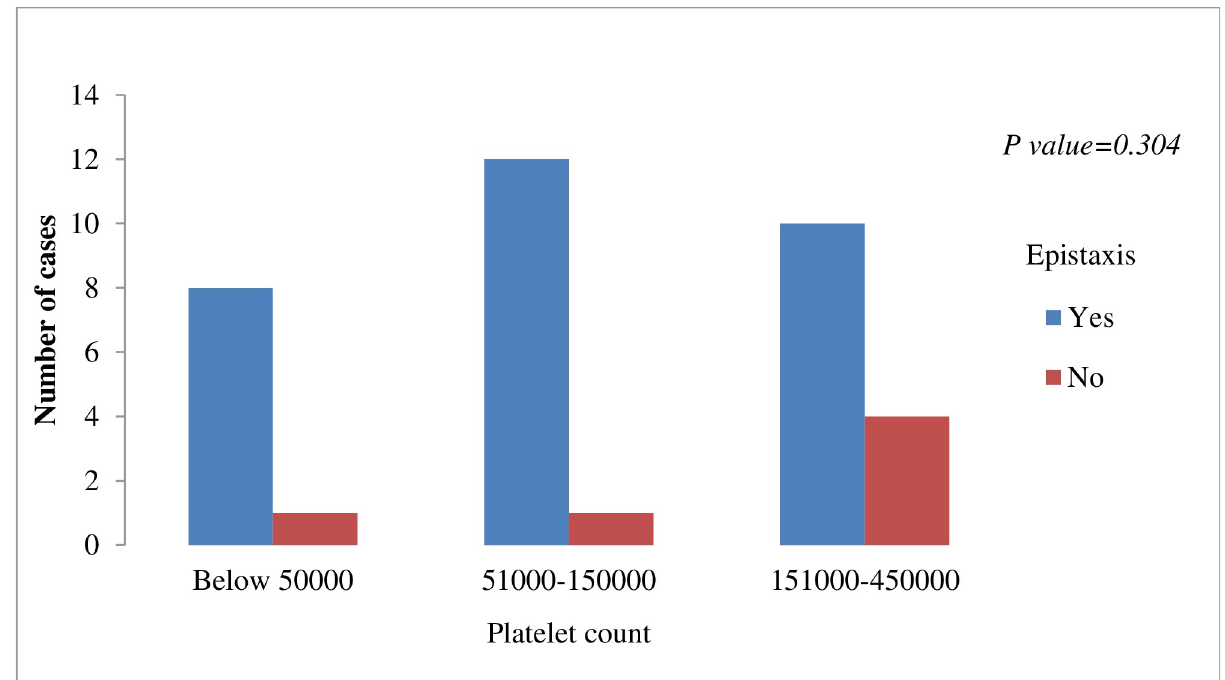
Fig 1. Thrombocytopenia and epistaxis in patients treated as LBRF at Jimma Medical Center, Ethiopia, May–July